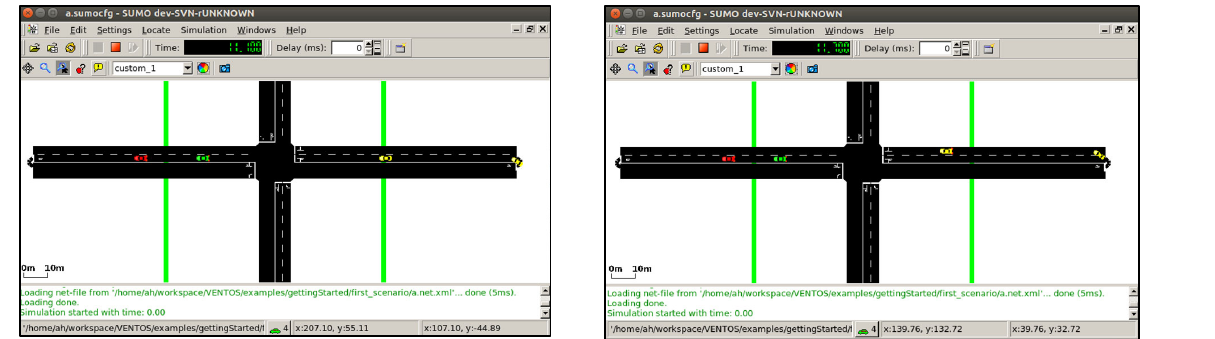
Fig. 9. Scenario 1: The RSU Communicates with the In- coming Vehicles